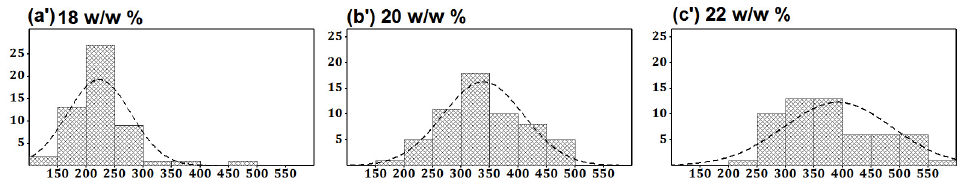
Figure 3. Histograms of nanofiber diameter at different concentration levels 18, 20, and 22 w / w % with constant applied voltage 45 kV and constant collecting distance 20 cm.